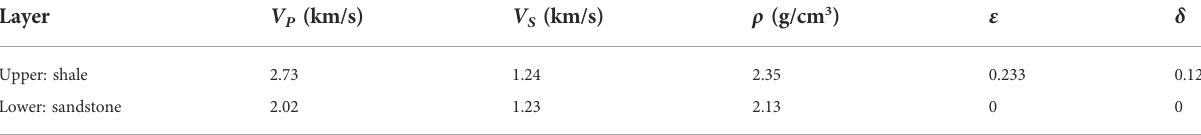
TABLE 1 Model parameters: the VTI/isotropy interface from Rüger [7]. Layer